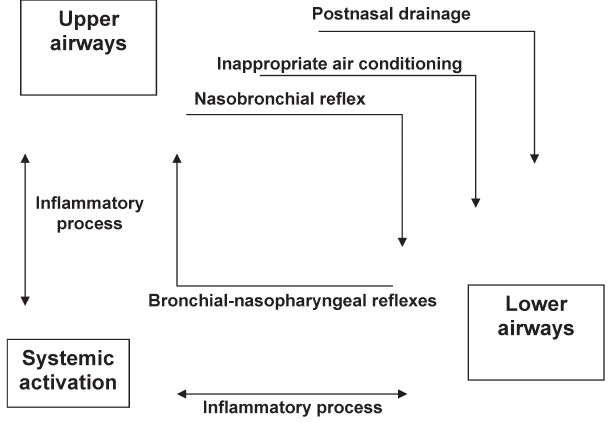
Figure 10 - Pathophysiological evidence for the interaction between allergic rhinitis and allergic